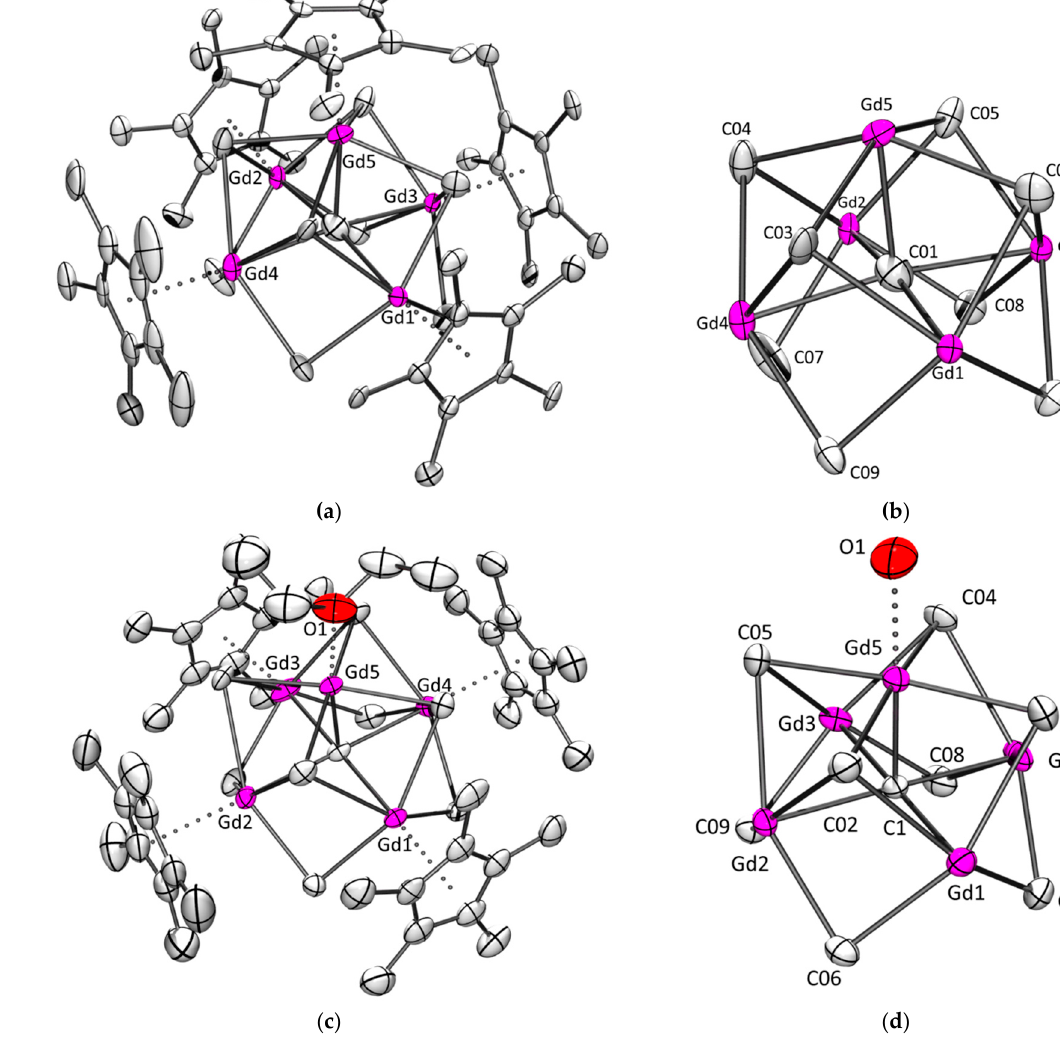
Figure 9. ORTEP view of the crystal structure ( a ) and detailed view of the bonding situation in the core structure ( b ) of [(Cp*Gd) 5 (CH 2 )(Me) 8 ] ( 3 Gd ). Panels ( c ) and ( d ) show the structure and the bonding situation in [(Cp*Gd) 4 {(Et 2 O)Gd}(CH)(Me) 8 ] ( 3a Gd ) likewise. Atomic displacement parameters are set at the 50% probability level. Hydrogen atoms, and in the case of 3a Gd , a second species of the complex and two molecules of n -hexane per asymmetric unit are omitted for clarity. See Table 7 for significant bond lengths and angles.